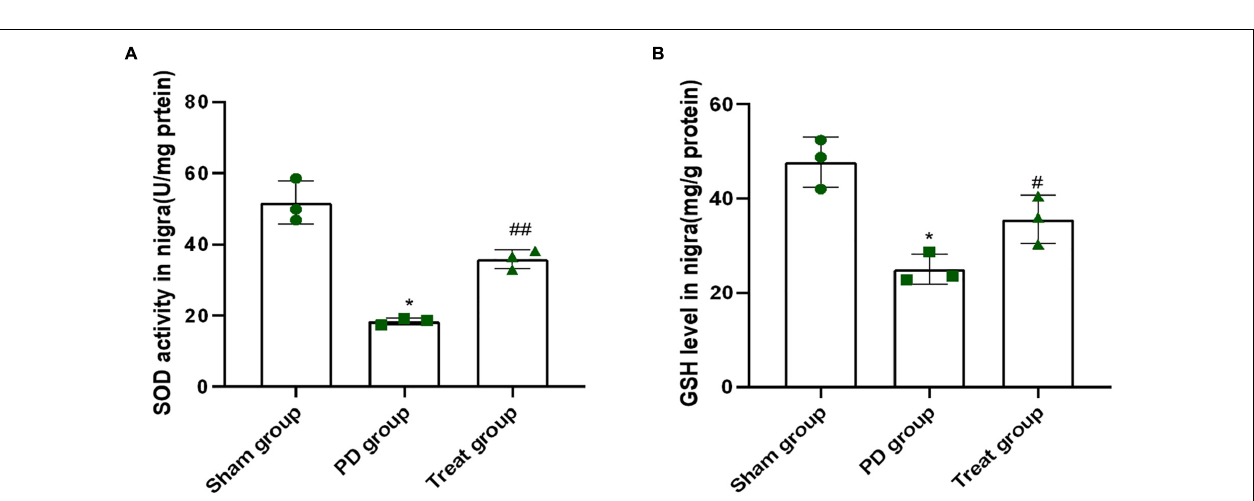
FIGURE 2 | ALA protected against 6-OHDA-induced damage of PC12 cells. (A) PC12 cells were incubated with different concentrations of 6-OHDA for 24 h. (B) PC12 cells were pretreated with ALA for 1 h and then exposed to 6-OHDA for 24 h. Data were expressed as the means ± SD analyzed by one-way ANOVA. Statistical significance: * P < 0.05, ** P < 0.01 vs. the control group; # P < 0.05, ## P < 0.01 vs. the PD group.